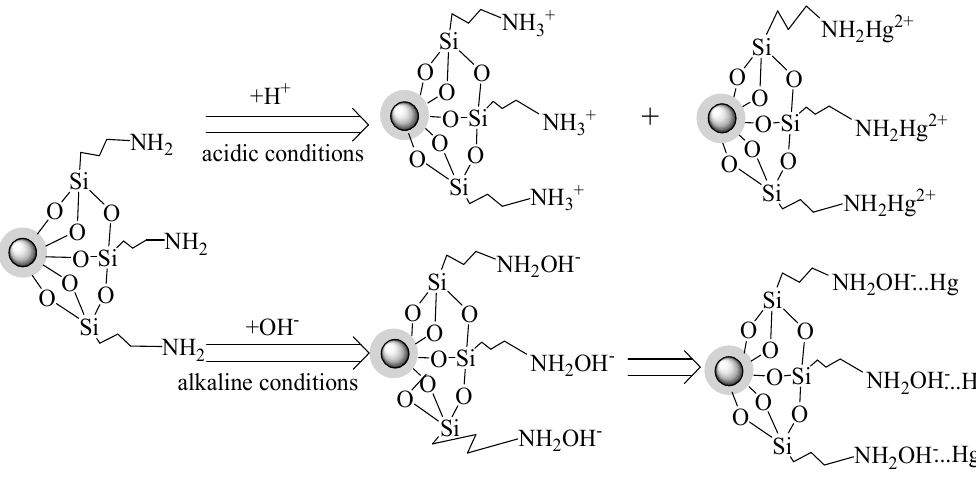
Figure 17. Possible mechanism of adsorption of mercury.